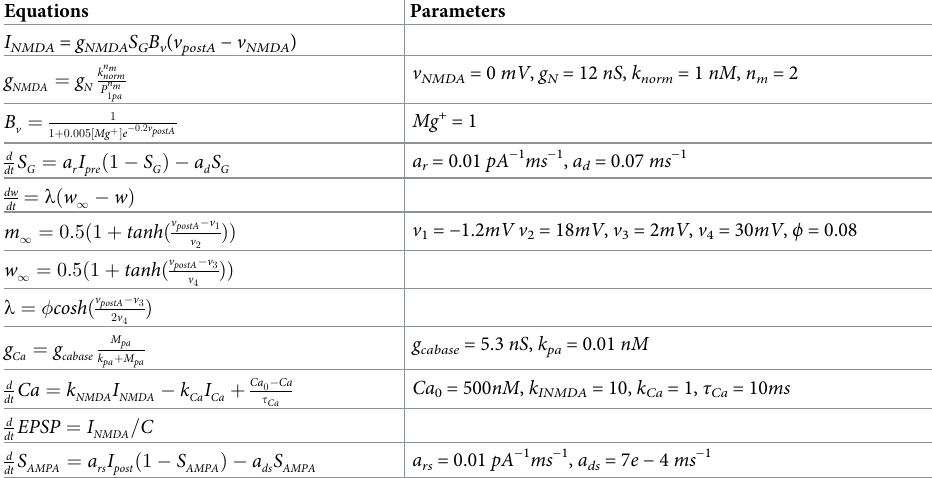
Table 1. Model equations and parameters for amygdala.